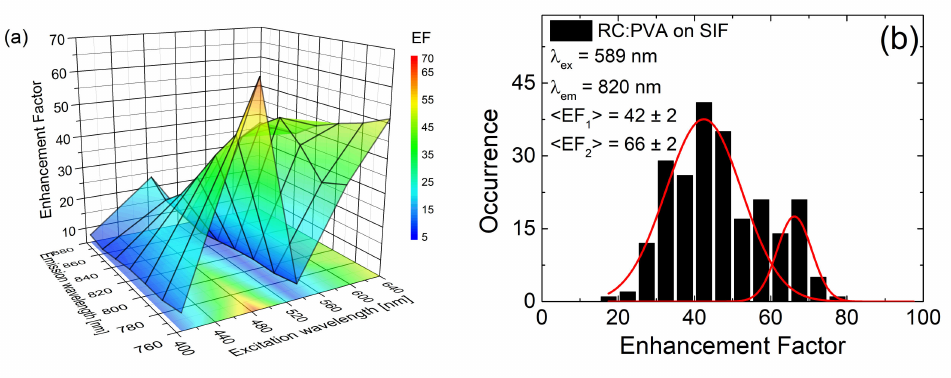
Figure 7. ( a ) Three-dimensional graph of enhancement factors (EFs) of emission intensities of Chlorobaculum tepidum RCs in function of excitation and emission wavelength; ( b ) histogram of EFs of RCs deposited on SIF (black bars) calculated for excitation at 589 nm and emission at 820 nm. Bimodal normal functions, fitted to the calculated EFs are shown (red lines) in the